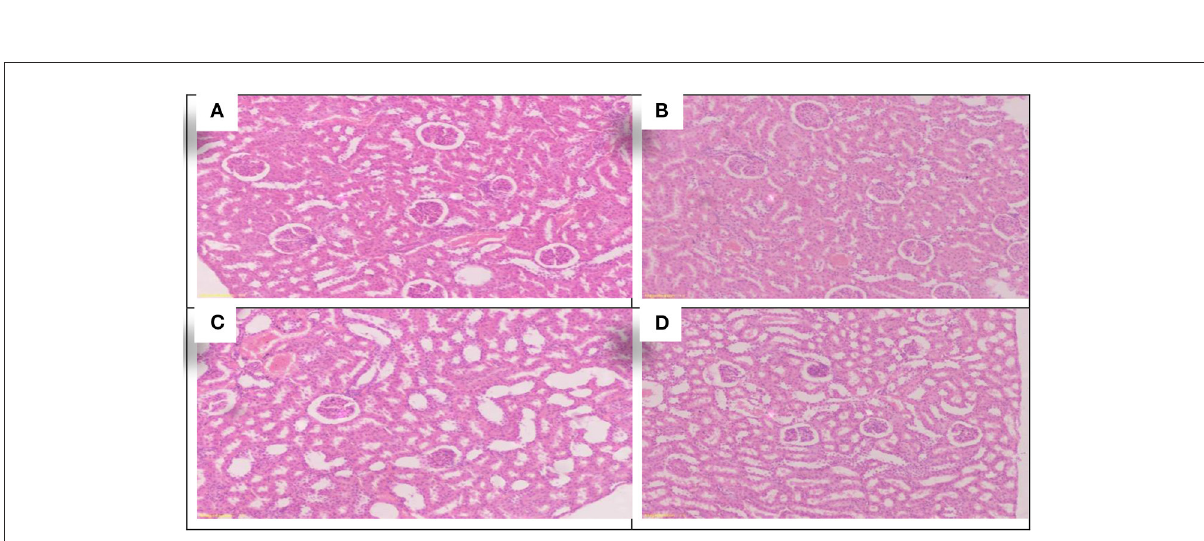
FIGURE6 Schematic diagram showing the effect of each aluminum, medicinal plant and mix with aluminum and medicinal plants on histopathology of rats’ Kidney during return to normal after exposure to aluminum toxicity at 60 day after treatment. (A) Control group. (B) Allium sativum 5%. (C) Nigella sativa 5%, and (D) Allium sativum 2.5% + Nigella sativa